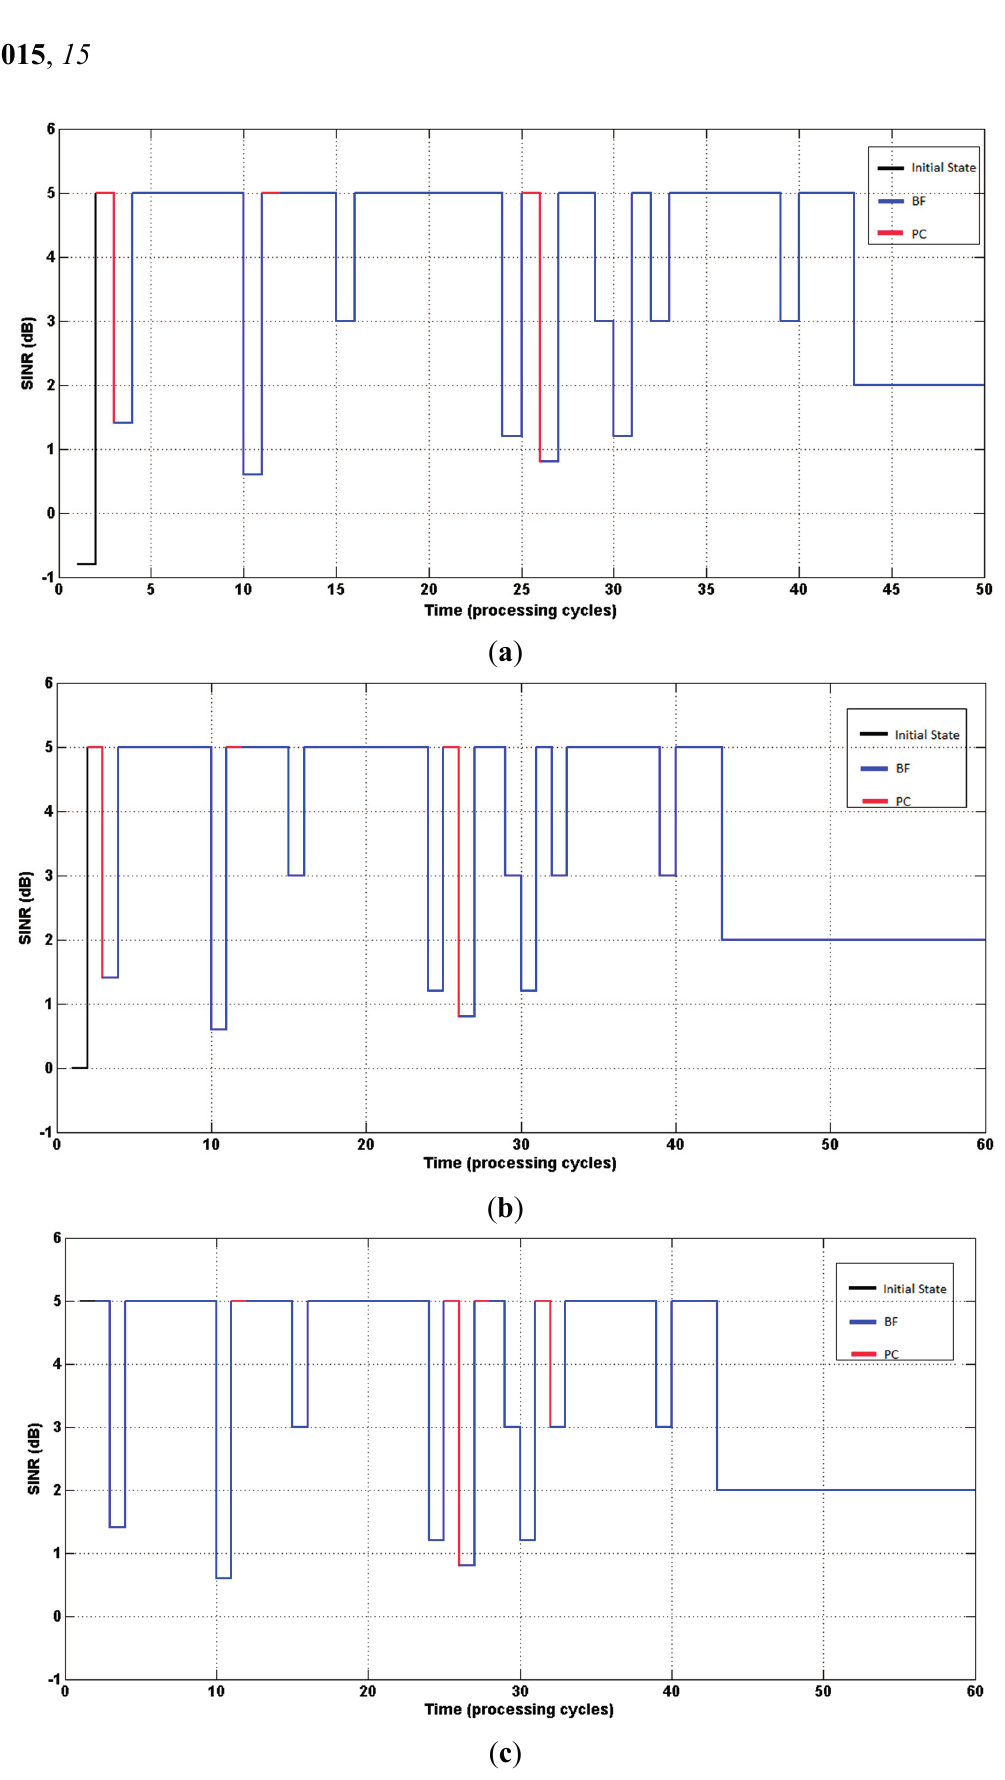
Figure 5. ( a ) System response. Agent started with SINR = − 0.8 dB; ( b ) System response. Agent started with SINR = 0 dB; ( c ) System response. Agent started with SINR = 5